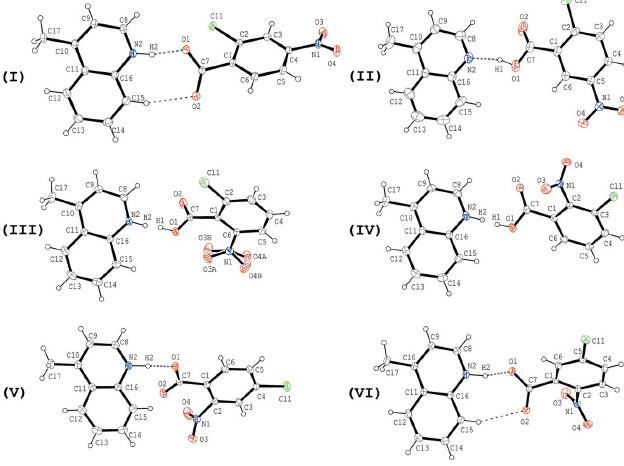
Figure 1 Molecular structures of the title compounds (I)–(VI), showing the atom- numbering scheme. Displacement ellipsoids are drawn at the 50% probability level and H atoms are shown as small spheres of arbitrary radii. In the hydrogen bonds between the carboxy O atom and the base N atom of compounds (III) and (IV), the H atoms are each disordered over two positions. The nitro group in (III) is disordered around the N1—C6 bond. Dashed lines in (I), (II), (V) and (VI) indicate the N—H (cid:2)(cid:2)(cid:2) O, O— H (cid:2)(cid:2)(cid:2) N and C—H (cid:2)(cid:2)(cid:2) O hydrogen